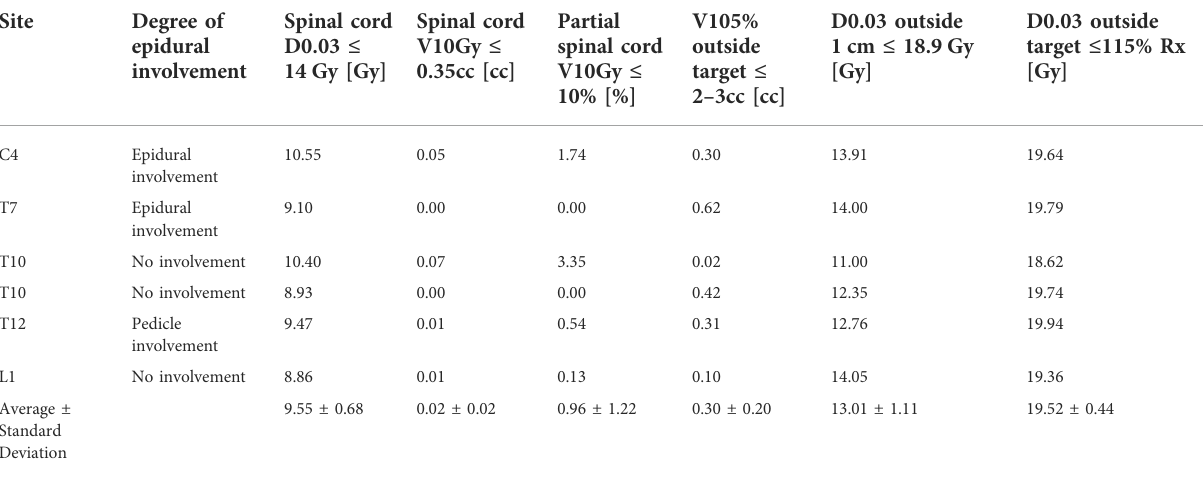
TABLE1Constraintsandplan qualitymetrics thatguidedplanningaresummarized inthe fi rstrowwith theindividualstatisticsfor eachretrospective plan in the following rows.